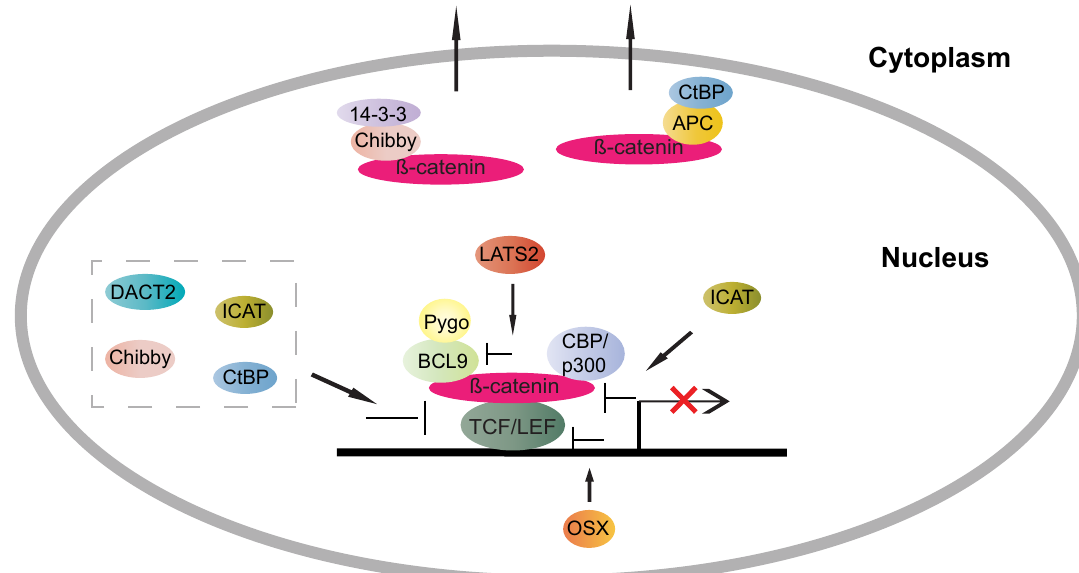
Figure 4. Schematic representing the molecular mechanism of transcriptional repression in TCF / LEF-dependent Wnt outcomes. B-catenin-TCF / LEF-regulated transcription can be